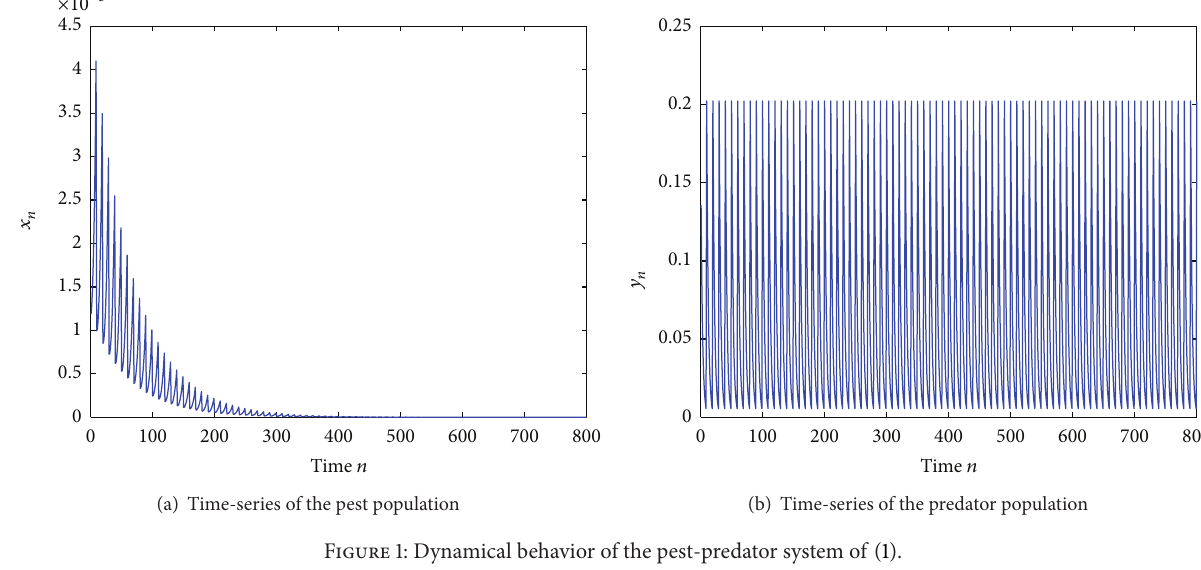
Figure 1: Dynamical behavior of the pest-predator system of (1).